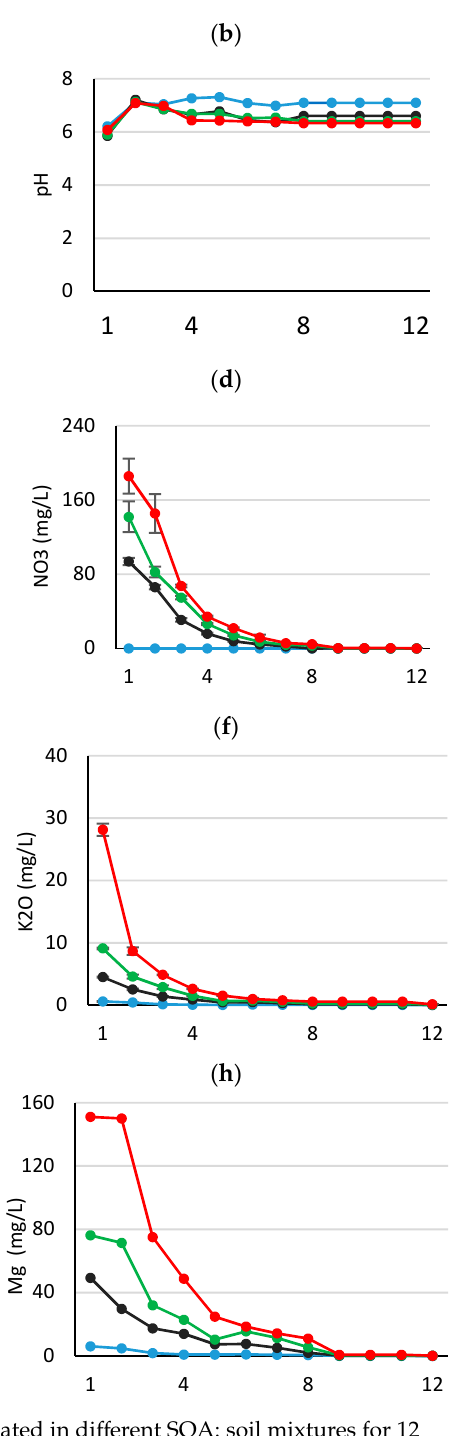
Figure 2. Dynamics of nutrients in irrigation water percolated in different SOA: soil mixtures for 12 days. Blue line: control (SOA 0% w / v ); purple line: SOA 5% w / v ; green line: SOA 10% w / v , red line: SOA 20% w / v . The errors bars correspond to the standar deviation calculated on three repetitions. ( a – h ) indicate the physical-chemical parameters evaluated.